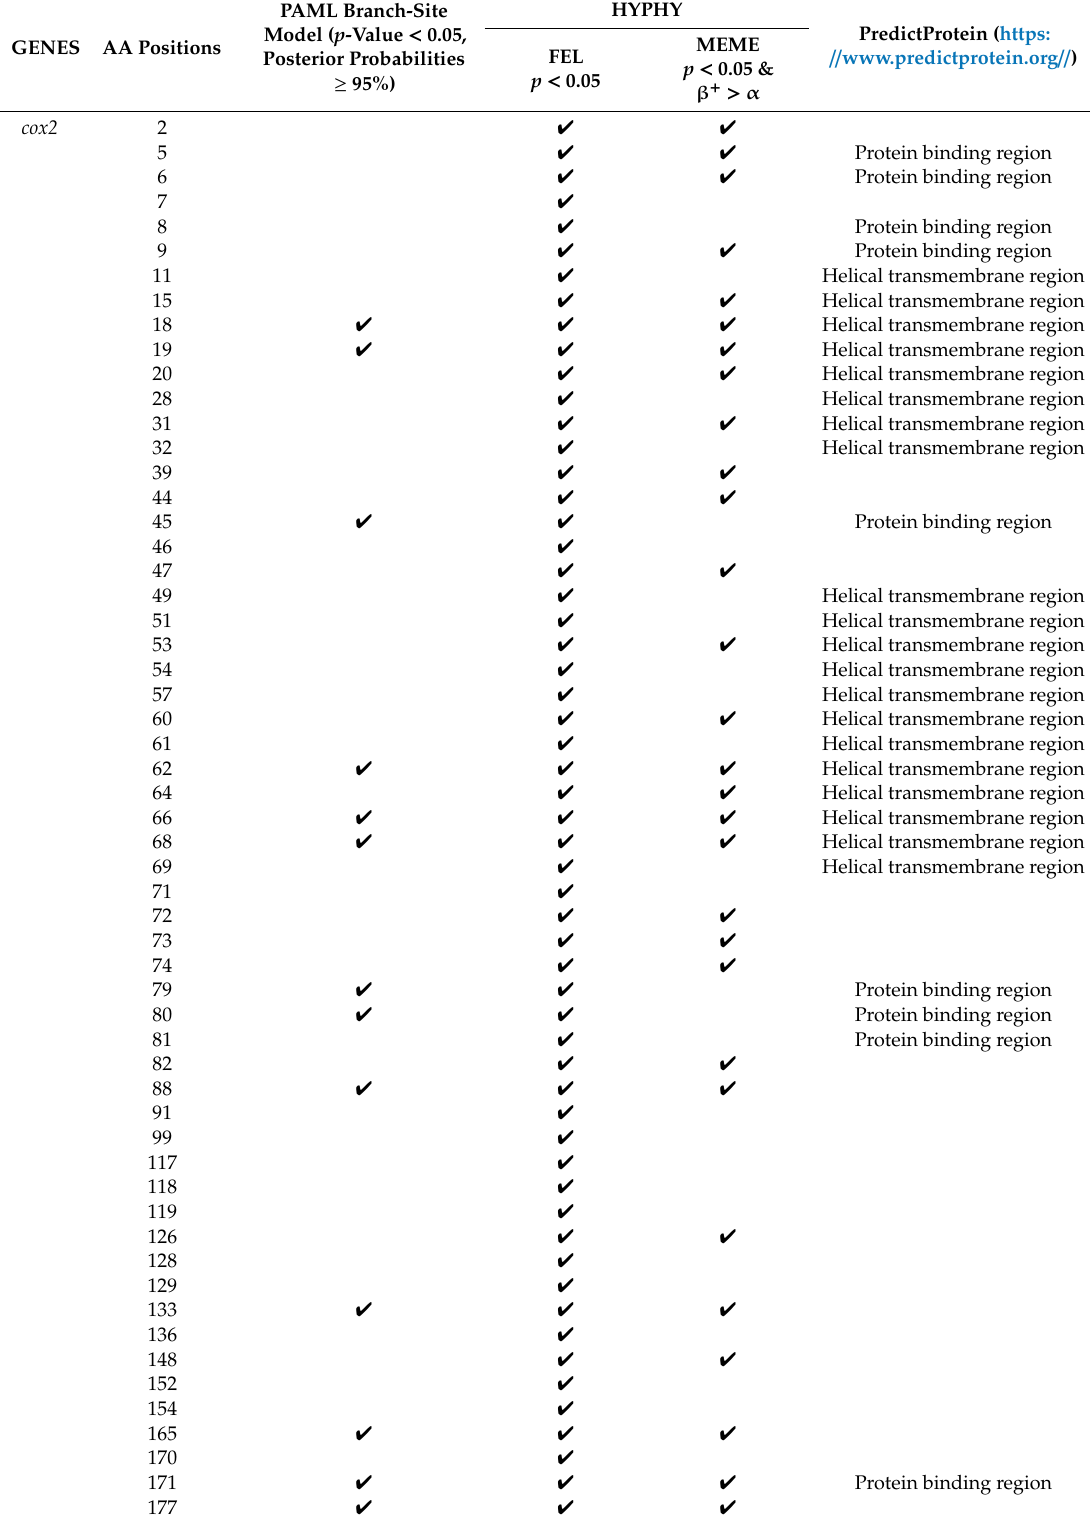
Table 2. Positively selected sites of cox2 and cox3 genes identified by PAML, and HYPHY.